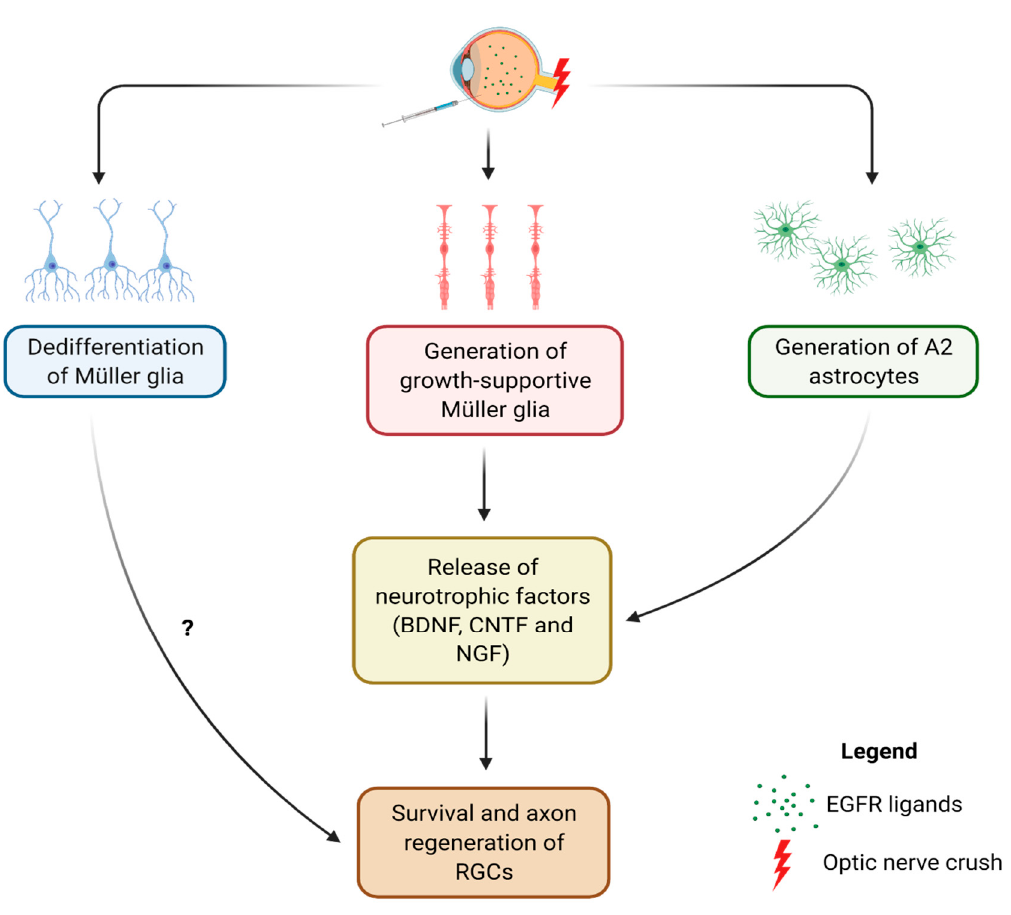
Figure 2. Intravitreal injection of EGFR ligands after ONC may lead to generation of A2 astrocytes and promote survival and axon regeneration of RGCs. It may also induce Müller cells to become more growth-supportive and help maintaining survival of RGCs and promoting optic nerve regeneration in cooperation with A2 astrocytes. Alternatively, Müller cells may dedifferentiate into retinal progenitor-like cells and contribute to survival and axon regeneration of RGCs (created with Biorender.com). Abbreviations: BDNF, brain derived neurotrophic factor, CNTF, ciliary neurotrophic factor, NGF, nerve growth factor, RGC, retinal ganglion cell, EGFR, epidermal growth factor.